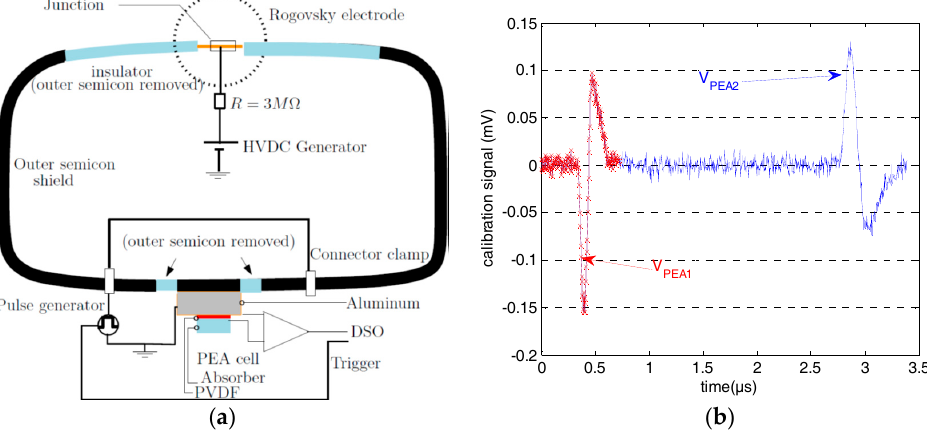
Figure 1. ( a ) Schematic of the Pulsed Electroacoustic (PEA) test bench for cable geometry. PVDF—Poly(vinylidene fluoride) is the material for the piezoelectric sensor. The cable is arranged as a loop so that an AC current can be created in it using a current transformer to reach the desired thermal conditions (thermal gradient); ( b ) Rough signal measured for the calibration step by applying 20 kV on a 4.5 mm thick insulation Medium Voltage (MV) cable [14].